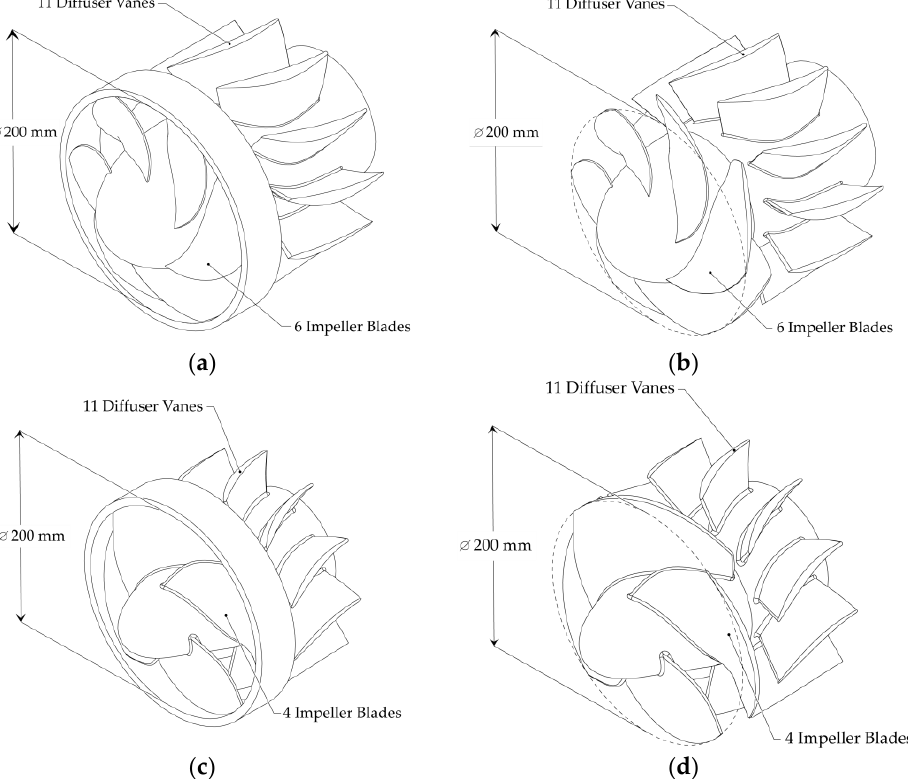
Figure 1. Axial-flow impeller variants: № 1: ( a ) Impeller № 1 with rim; ( b ) Impeller № 1 without rim; ( c ) Impeller № 2 with rim; ( d ) Impeller № 2 without rim.